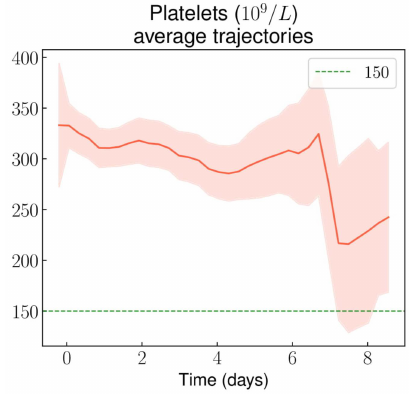
Figure A5. Platelet count average trajectory throughout non-complicated VOC-related hospital